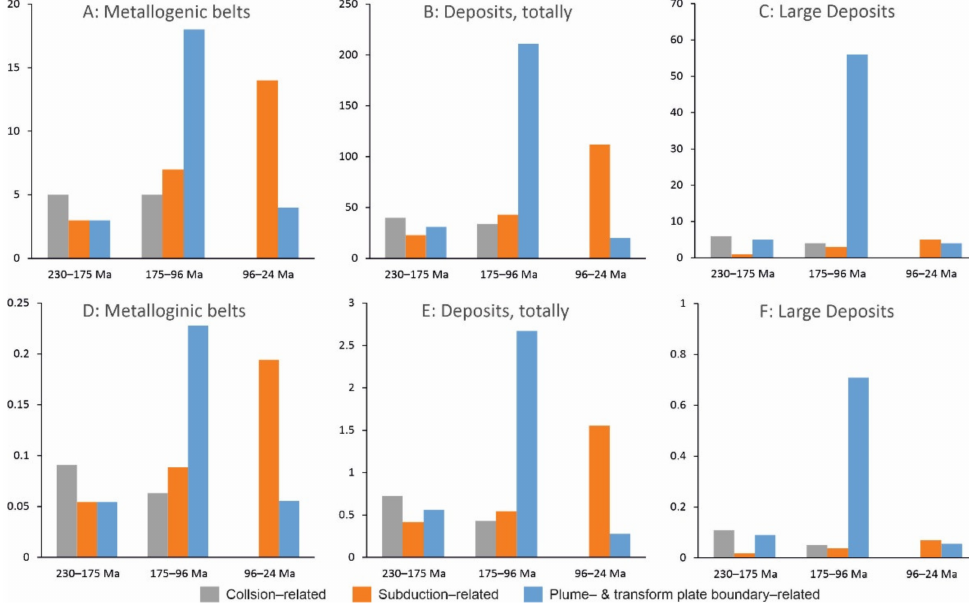
Figure 4. Age distribution of metallogenic belts and mineral deposits of NE Asia based on the data from [3,4]: ( A – C )—total numbers, ( D – F )—total number vs. duration of the corresponding metallogenic epoch (in million